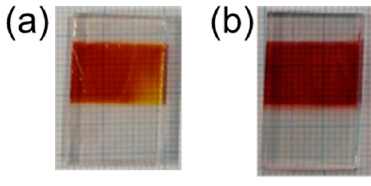
Figure 2. Photographs of ( a ) photochemically and ( b ) thermally modified TiO 2 electrode by pDSBT .